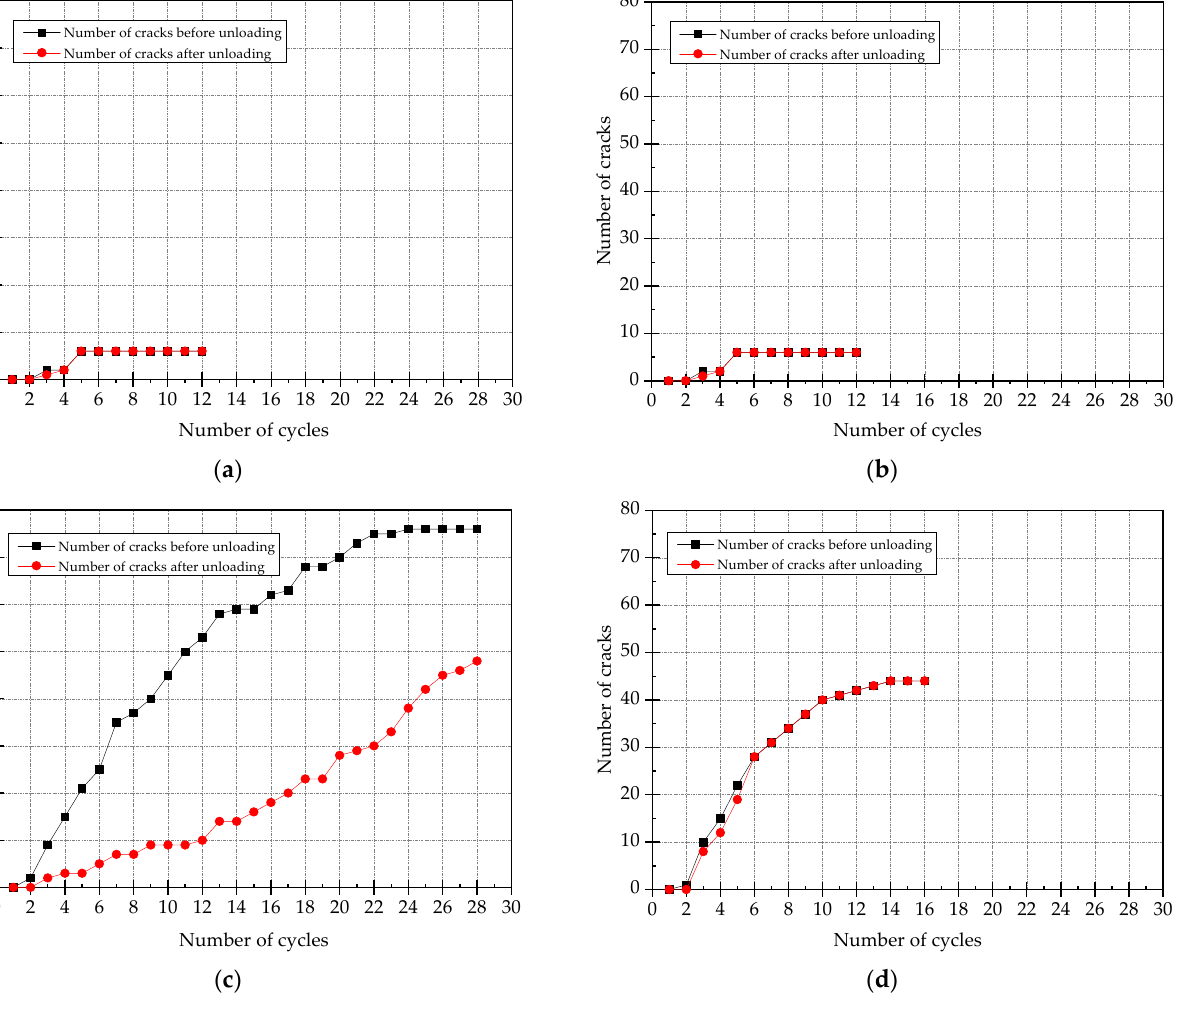
Figure 13. The curves of number of cracks under loading and unloading. ( a ) SJ-1; ( b ) SJ-2; ( c ) SJ-3; ( d ) SJ-4. ( d )